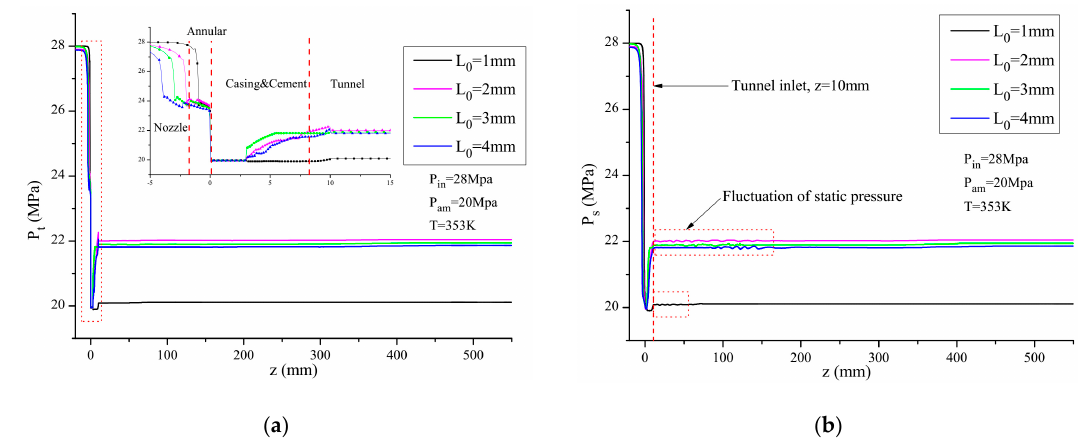
Figure 13. The e ff ect of nozzle outlet length on total pressure and axial static pressure. ( a ) Total pressure on the perforation; ( b ) Axial static of jetting.